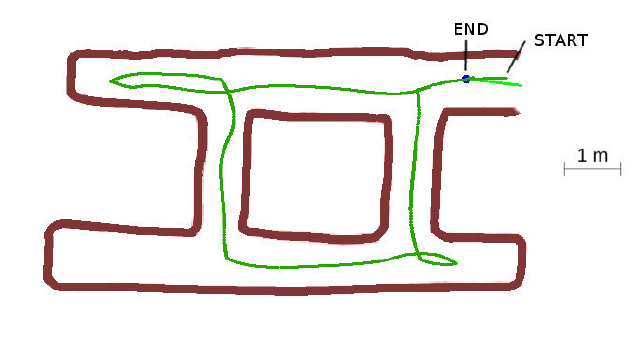
Figure 22. Cyclic labyrinth.